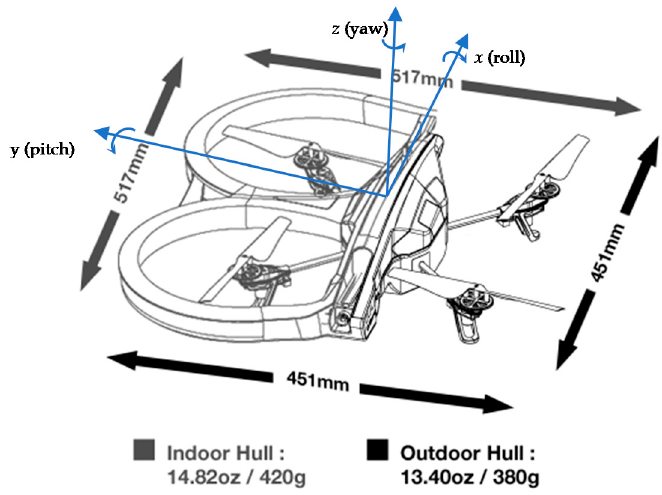
Figure 2. Parrot AR.Drone 2.0 and coordinate system.